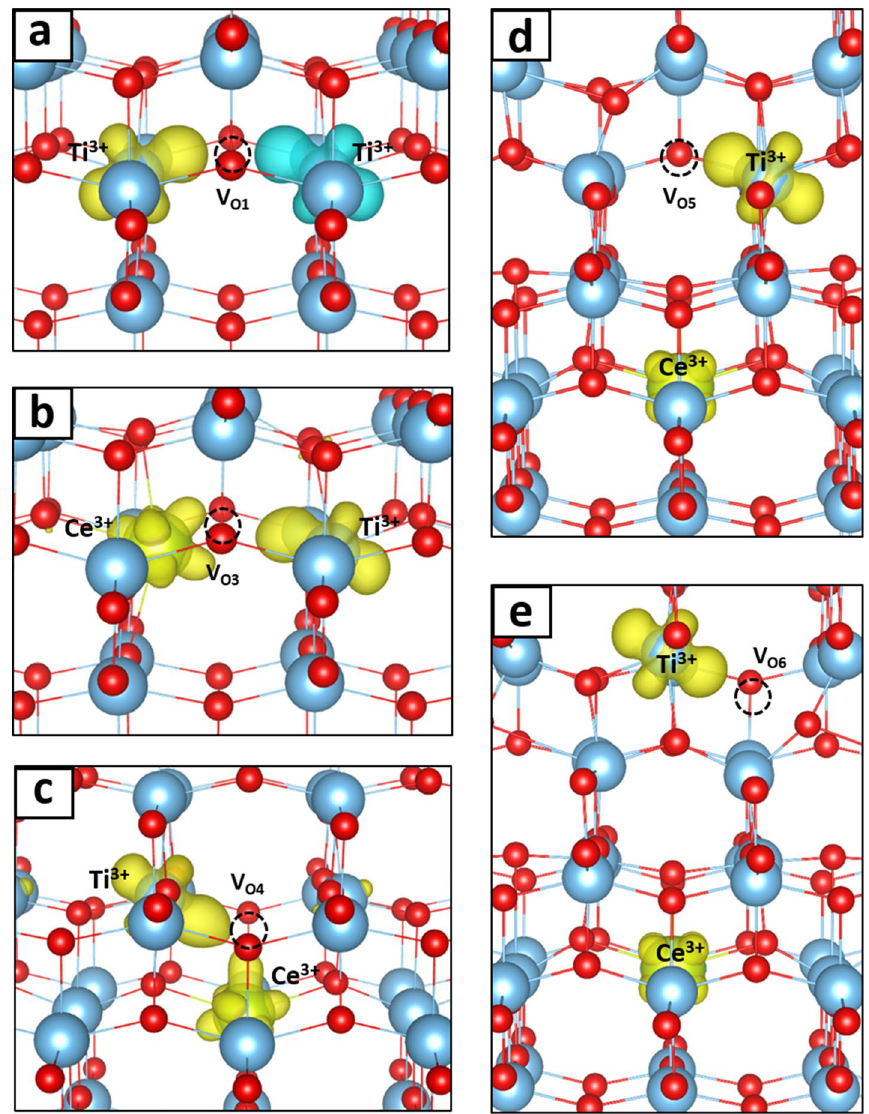
Figure 7. Structure and spin density isosurface of ( a ) oxygen vacancy V O1 , ( b ) oxygen vacancy V O3 , ( c ) oxygen vacancy V O4 , ( d ) oxygen vacancy V O5 , and ( e ) oxygen vacancy V O6 . The α and β spin densities are shown in yellow and blue, respectively. See text for a more detailed description of the different structures. Isosurface: 0.006 e − /Å 3 . This figure was drawn by using the VESTA 3 software 20 . https:// jp- miner als. org/ vesta/ en/ downl oad.